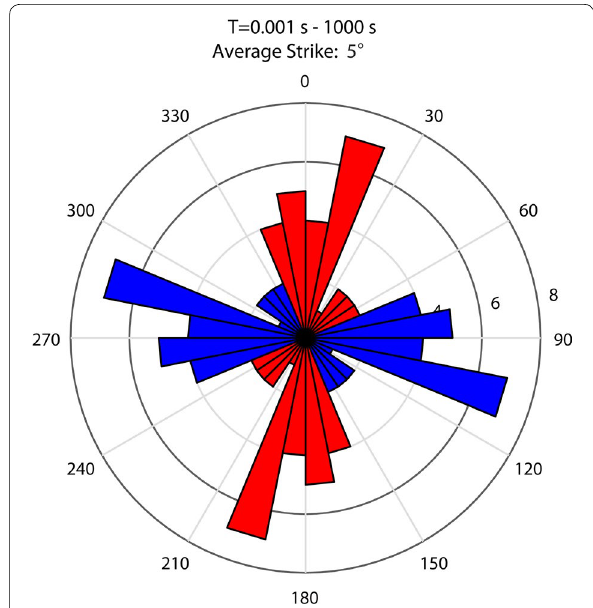
Fig. 3 Rose diagram showing the geoelectric strike direction for 0.001–1000 s for stations used in 2D inversion using the strike decom‑ position program of McNeice and Jones